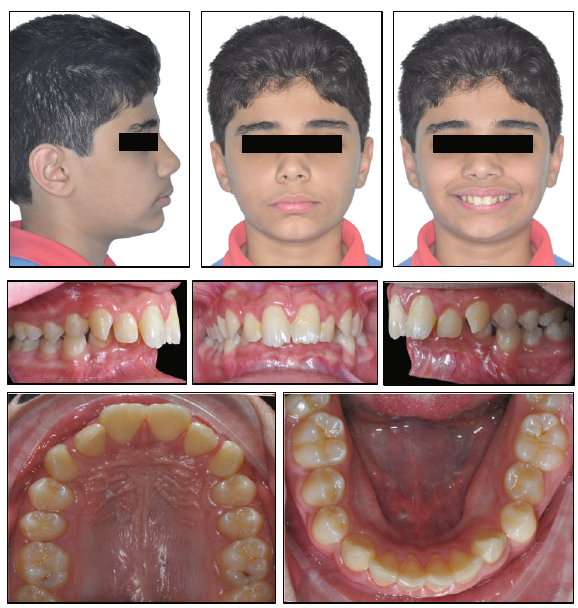
Figure 1: Pretreatment facial and intraoral photographs.